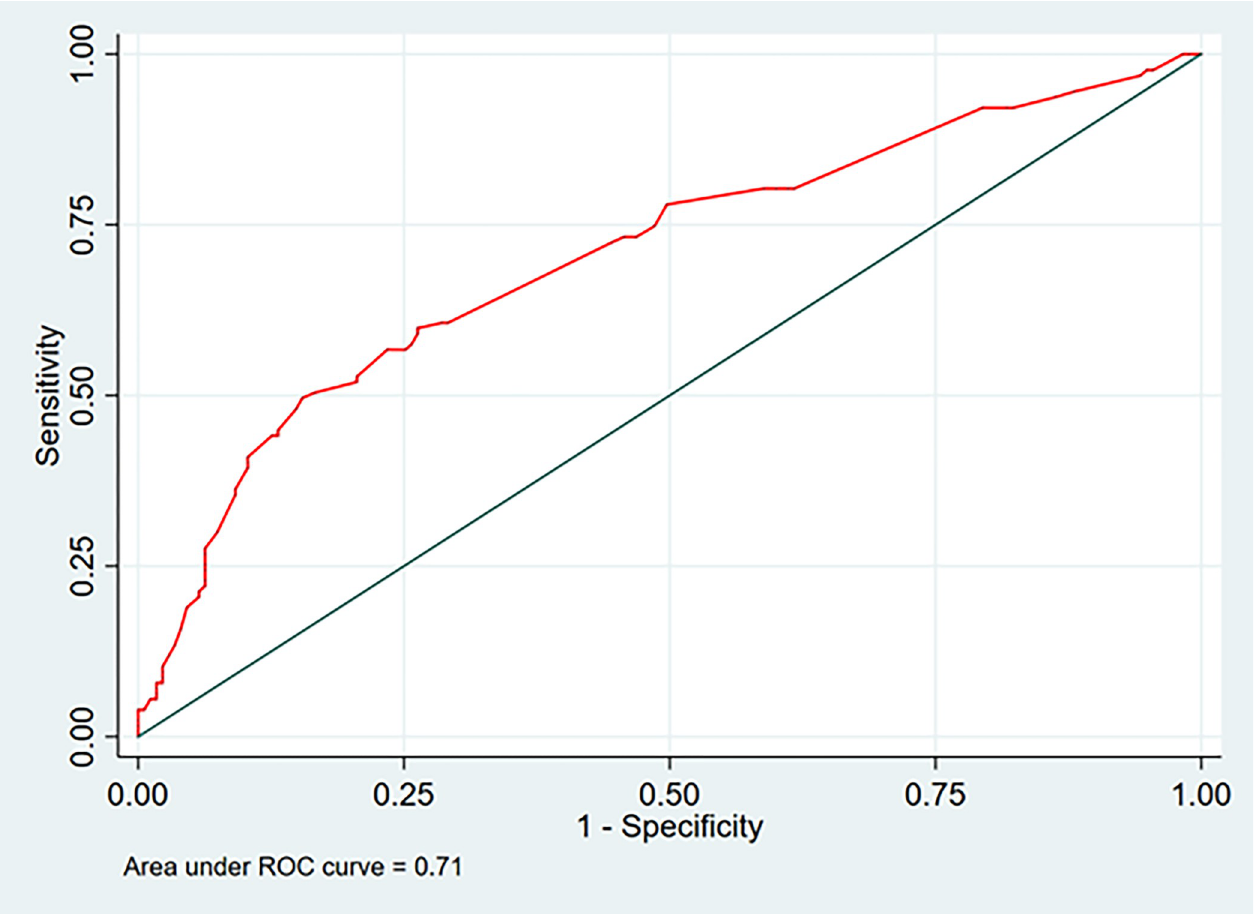
Fig 1. Area under the receiver operating curve (AuROC) of the predictive model for primary aldosteronism incorporating clinical and biochemical factors predicted by the predictive factors (red curved line).